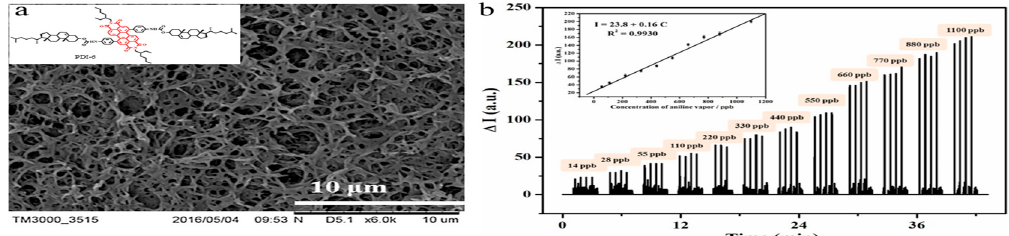
Figure 8. ( a ) SEM image of nanofibers (deposited as a film) assembled from PDI-6. Also shown are the molecular structure of PDI-6; ( b ) The fluorescence intensity change measured over a PDI-6 nanofiber film upon exposure to simulated breaths containing different concentrations of aniline. Inset shows the linear relationship between the fluorescence response and concentration of aniline. Note: the simulated breath samples were prepared by adding different concentrations of aniline in the breath samples collected from healthy people [66].